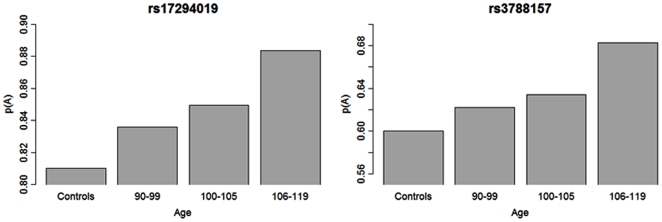
Age related trend of allele frequencies.The two barplots show the age related trend of allele frequencies of SNPs rs17294019 (ADARB2, SNP # 98 in Table 1) and rs3788157 (ADARB1, SNP # 135 in Table 1) in the NECS (n = 1,023). The frequencies of the common allele for both SNPs were stratified in the age groups 90–99; 100–105, 106 and higher. Trends of allele frequencies for increasing age groups are consistent with a strong correlation between genotype and phenotype that results in substantial enrichment of protective alleles in older subjects.